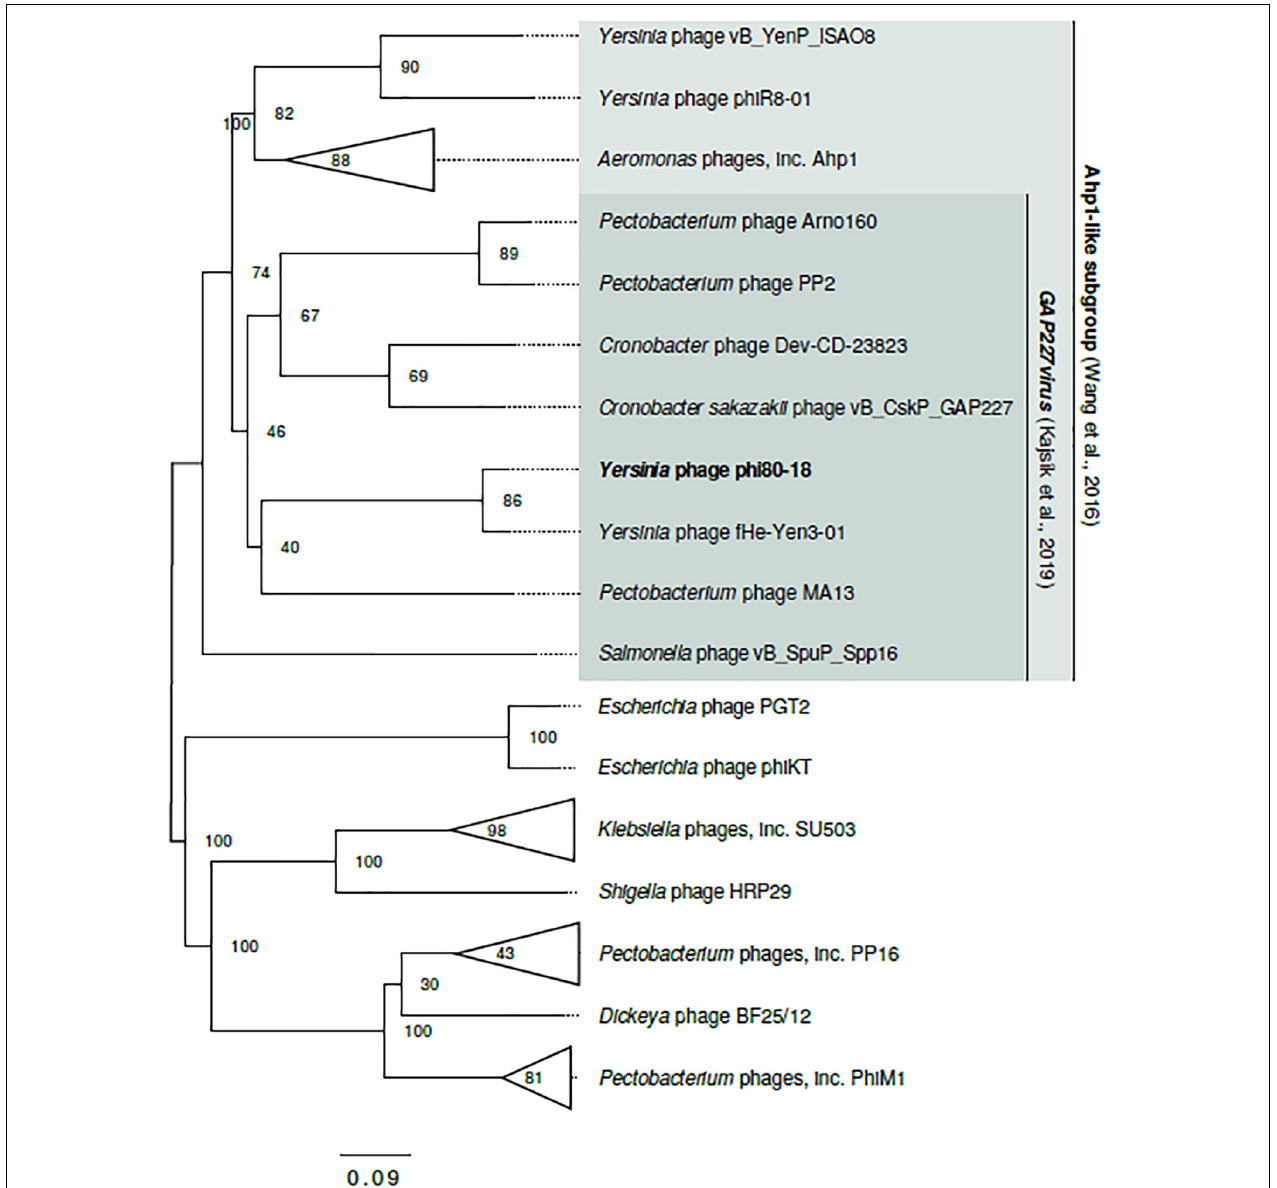
FIGURE 2 | Genome-based phylogram of Autographivirinae representatives closely related to φ 80-18. Node labels are bootstrap values. Ahp1-like subgroup (Wang et al., 2016) and Gap227virus genus (Kajsík et al., 2019) are proposed, yet not recognized by ICTV taxonomy (2018b Release). Here, both groups are extended beyond the range of taxa proposed in the original publications to cover the full cluster. The complete topology of the tree is shown in Figure 3